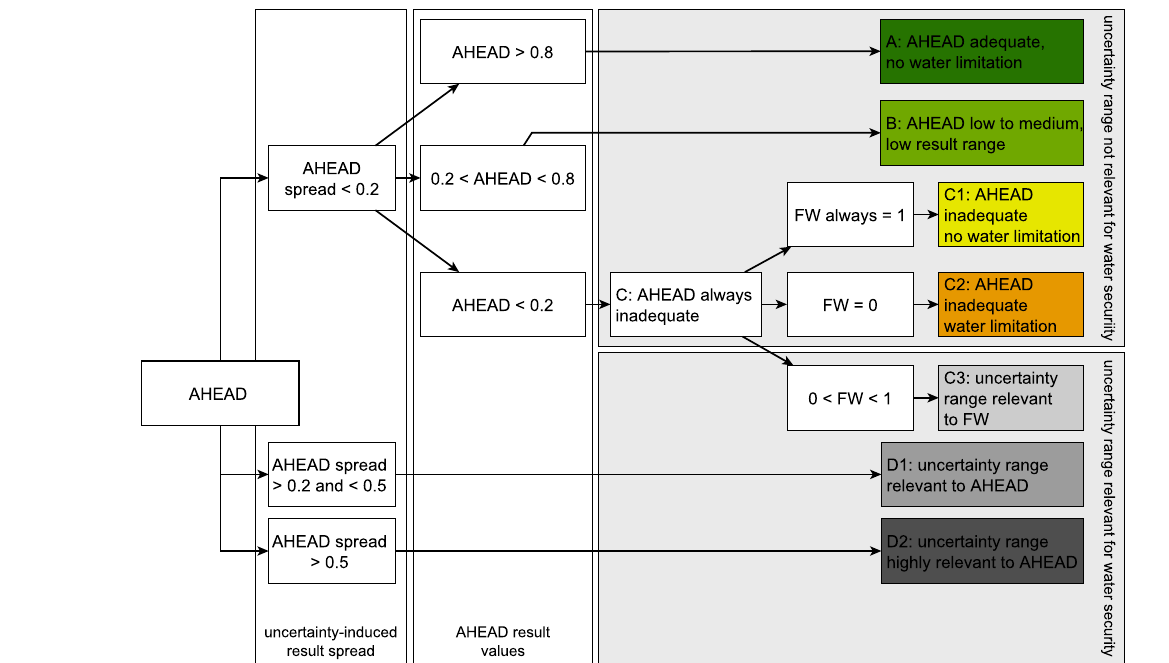
Figure 2. Decision tree to classify AHEAD results according to the result range of water availability data. Note that the term “range” in the figure refers to the range of result values for a single country, deriving from the range of values of water resource of availability from the different IM–GCM–RCP combinations. FW refers to fuzzified values of water availability. Classes A, B and C.1, C.2 comprise results which show a low range of values, indicating that the uncertainty-induced result range lies outside relevant boundaries for adequate AHEAD conditions and water security. In class C.3 and all D classes, uncertainty ranges are relevant with regard to AHEAD conditions and/or water security.